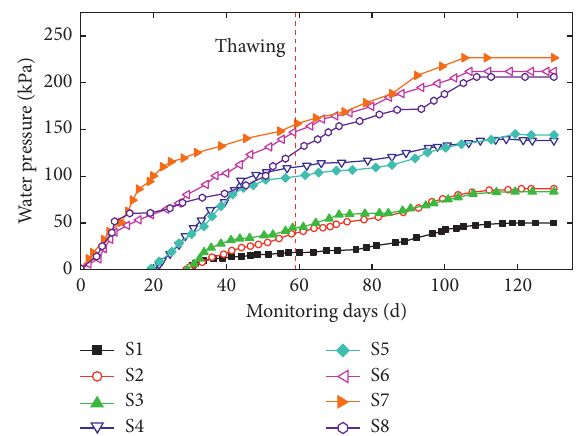
Figure 26: Water pressure outside the waterproof board.